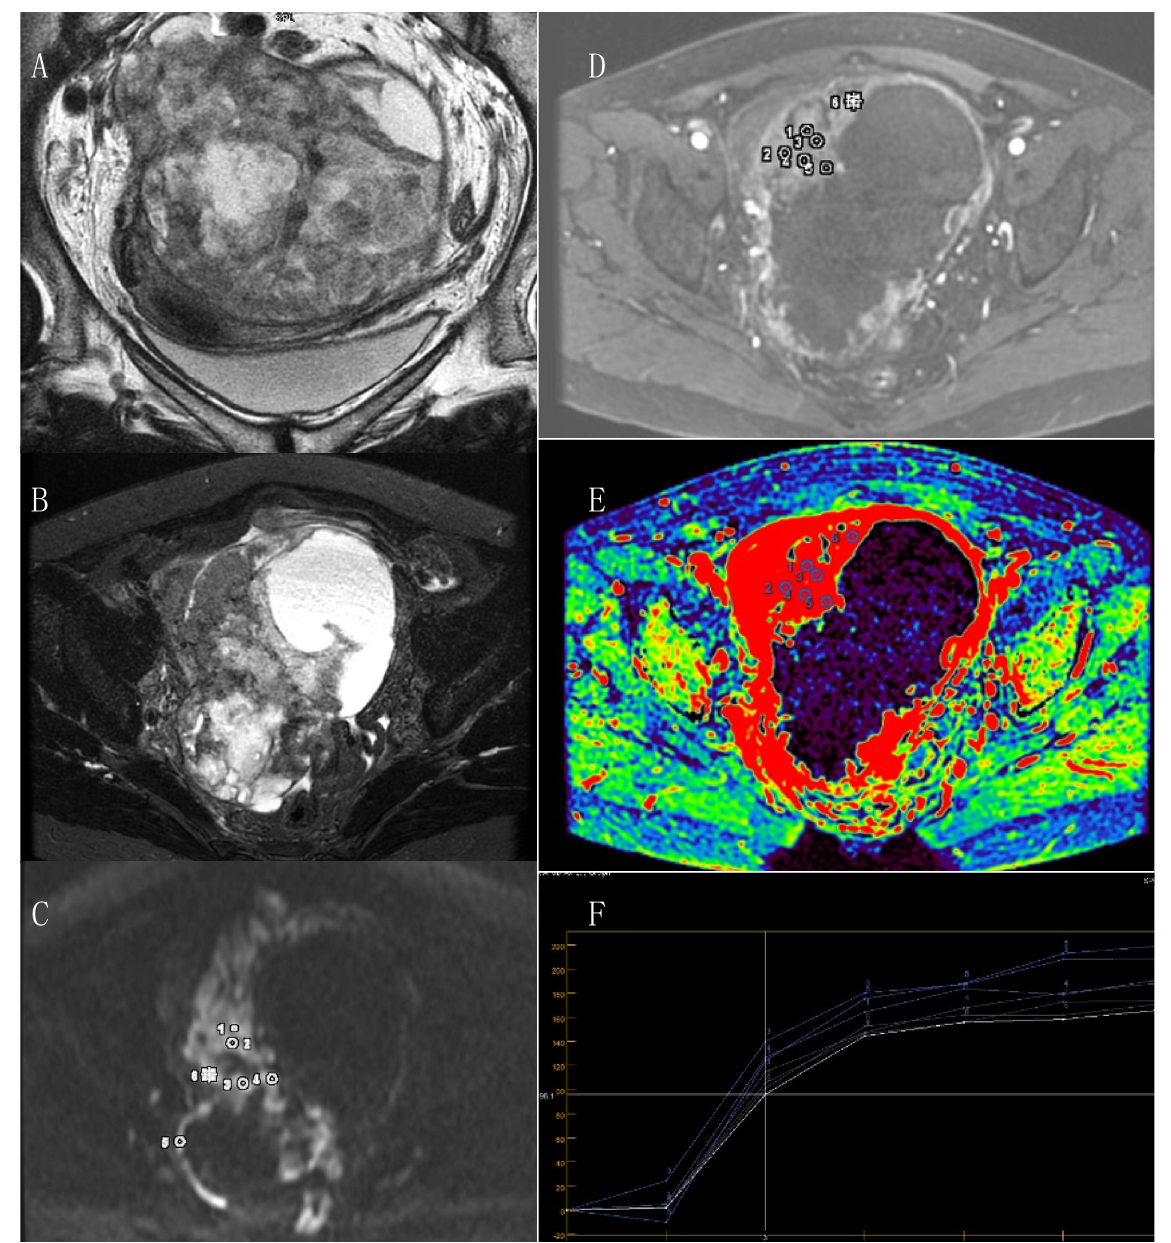
Figure 3. Images from 64-year-old women with high-grade serous ovarian cancer. ( A ): A large primary ovarian cancer cystic and solid part on T2-weighted; ( B ): T2 STIR; ( C ): DWI (b1500); ( D – F ) dynamic contrast enhancement small ROI is placed on a region appearing to be the most enhancing solid part of the tumor.